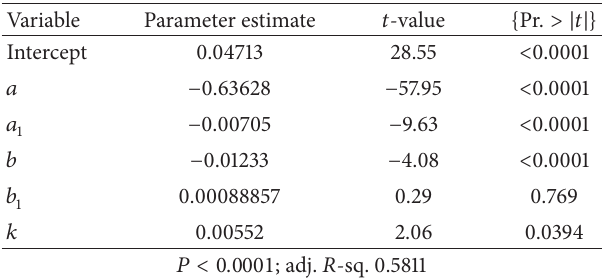
Table 4: Statistics of multiple linear regression for sampling level.